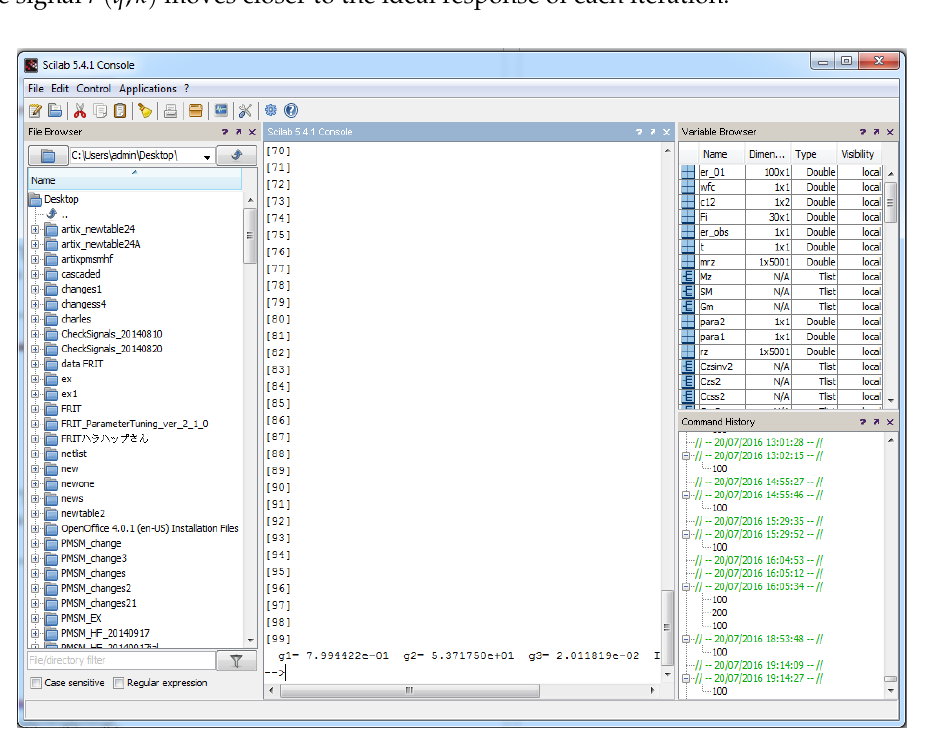
Figure 17. The value of the PI-P controller tuned by FRIT. g 1 = K P 1 , g 2 = K I and g 3 = K P 2 .